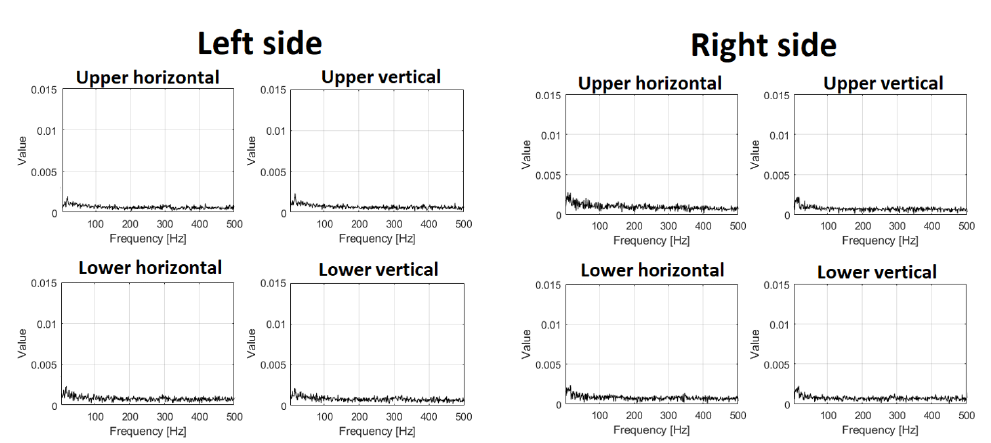
Figure 13. Envelope spectrum after